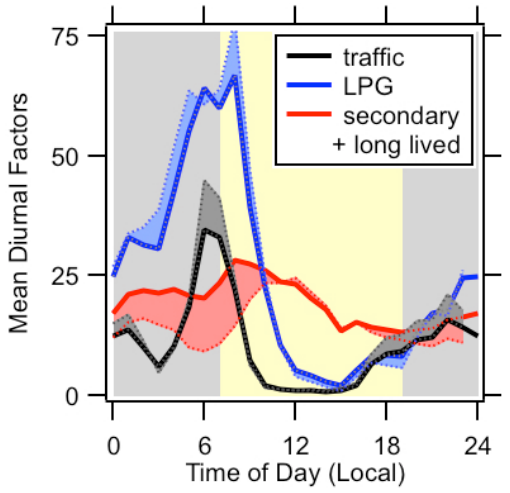
Figure 11. Mean diurnally averaged profiles for the 3-factor PMF solution obtained from MILAGRO 1041 Fig. 11. Mean diurnally averaged profiles for the 3-factor PMF so- lution obtained from MILAGRO VOC measurements. Solid lines VOC measurements. Solid lines represent the mean diurnal profile for each factor at FPEAK 0 while 1042 represent the mean diurnal profile for each factor at FPEAK 0 while the shaded regions bordered with dashes show the variation from the shaded regions bordered with dashes show the variation from the FPEAK = 0 solution over the 1043 the FPEAK 0 solution over the FPEAK range from − 3.0 to FPEAK range from -3.0 to +3.0. 1044